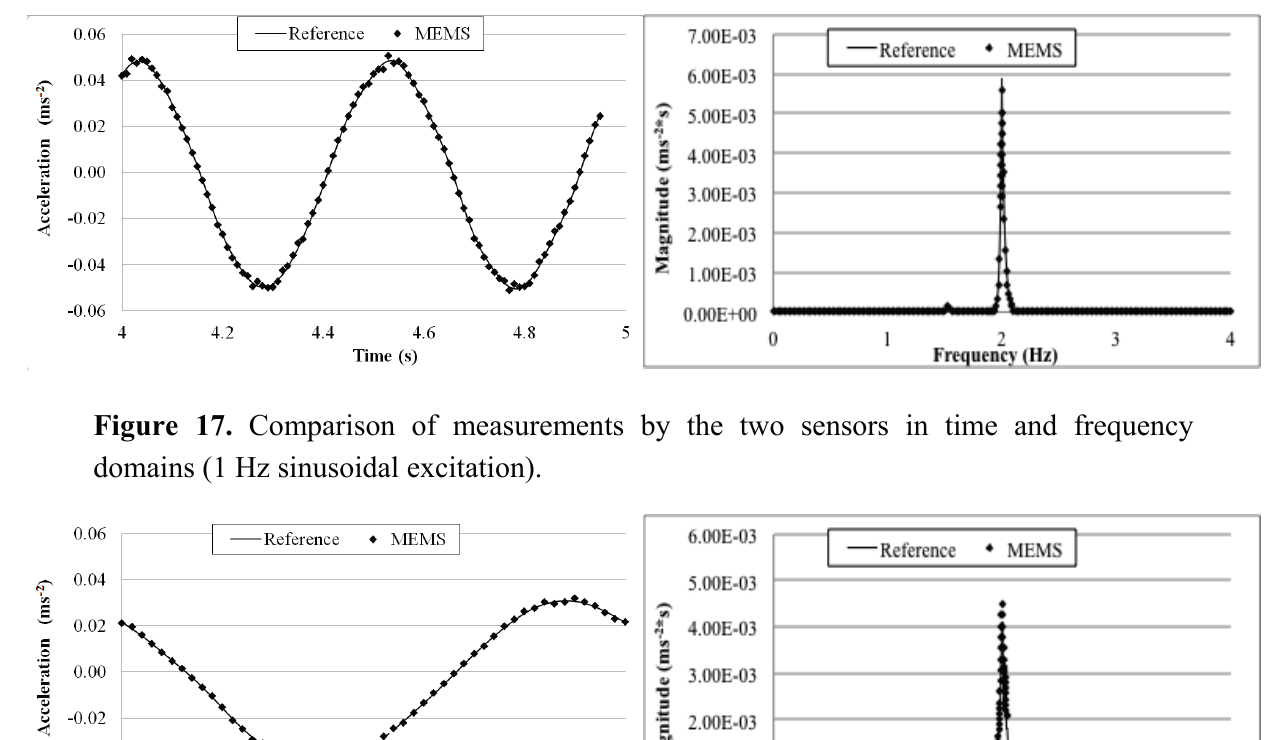
Figure 16. Comparison of measurements by the two sensors in time and frequency domains (2 Hz sinusoidal excitation).